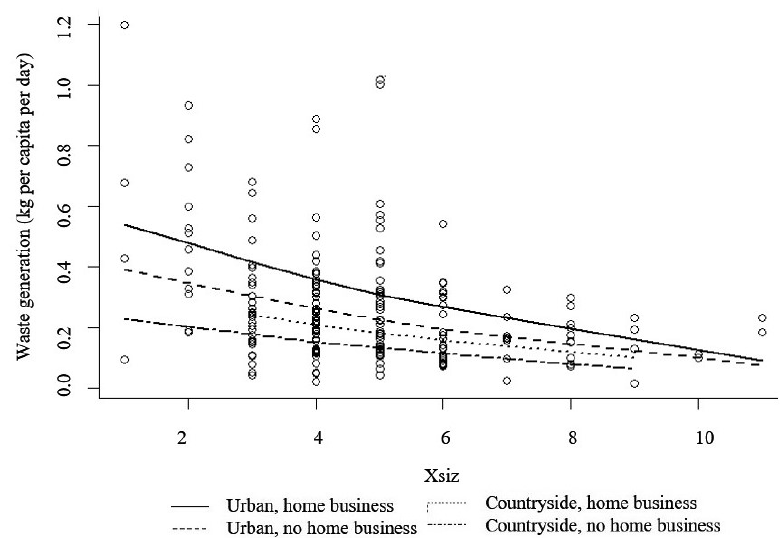
Fig. 5: Fitted line plot of model with three regressors Xplc, Xsiz, and Xbus